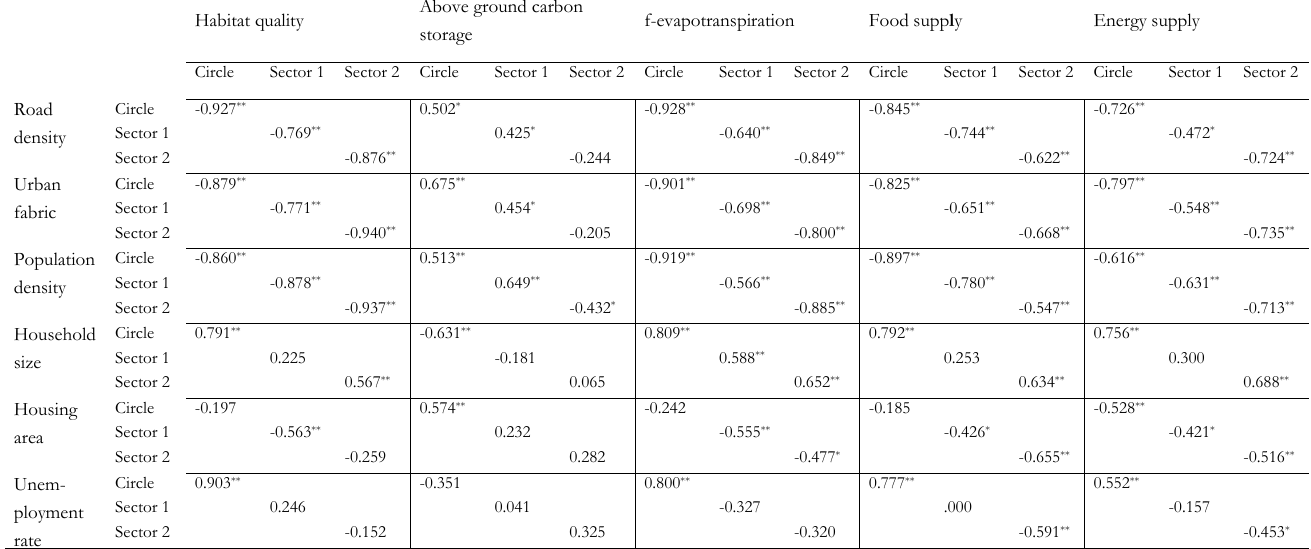
Table 2: Spearman correlations between the ecosystem service and socioeconomic gradients of the circle and sector areas in the Leipzig urban-rural area. The sample values are the mean values of the indicators in the associated rings with all sample sizes of 25 (25 concentric rings in the circle area and 25 concentric sector rings in both of the two sectors). ** P < 0.01, * P <0.05